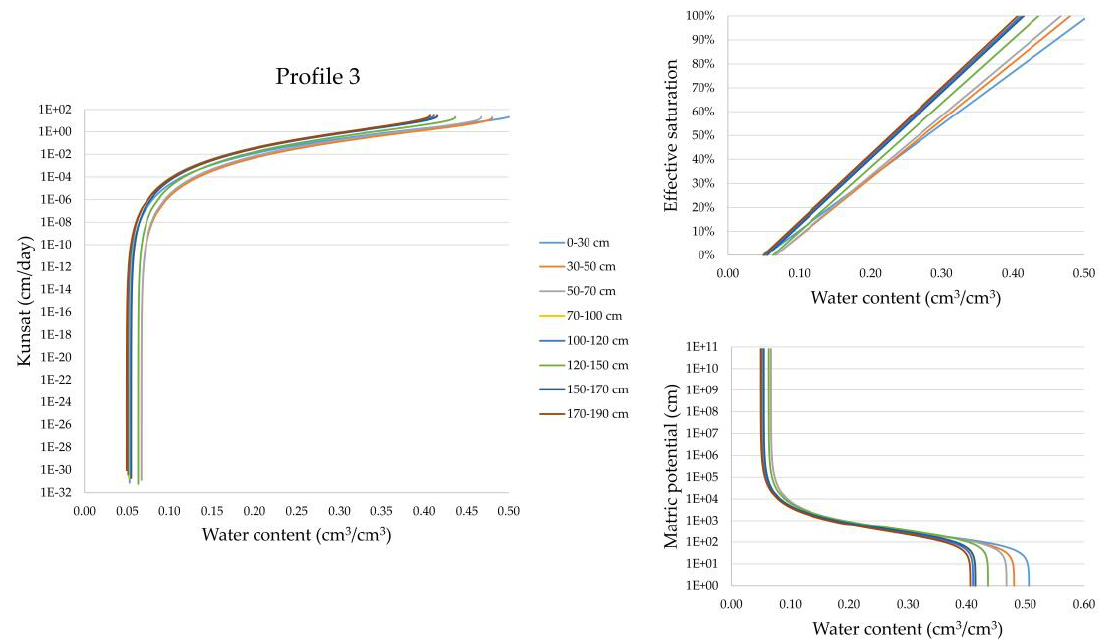
Figure 4. SWRCs, effective saturations, and unsaturated hydraulic conductivities in soil profile 2.